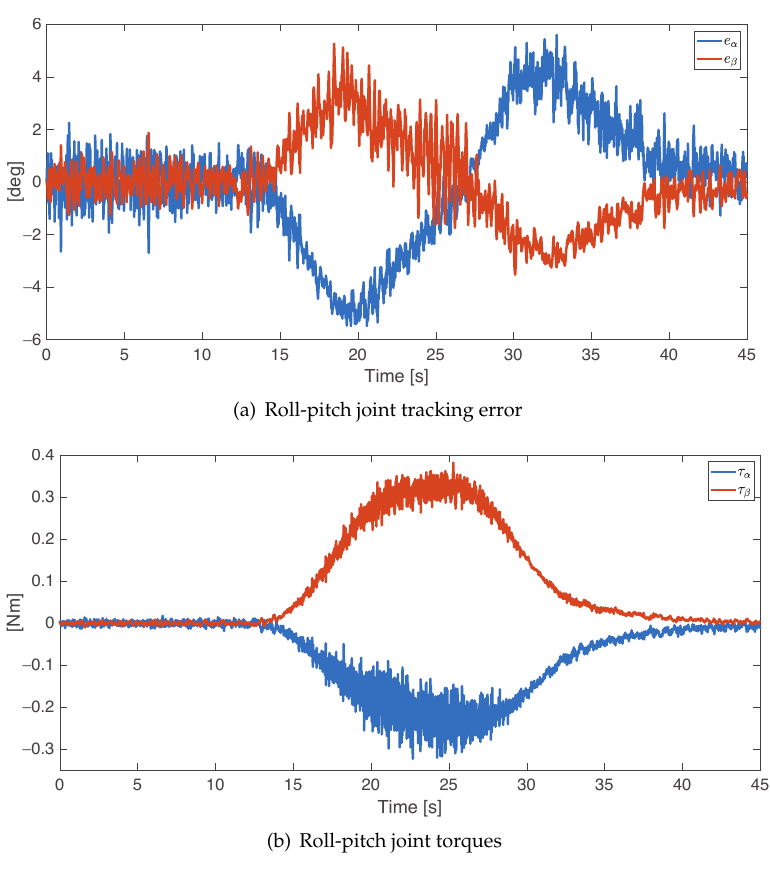
Figure 8. Second case study: roll-pitch joint tracking error ( a ) and torques ( b ). Finally, the estimated interaction forces and torques, computed via the observer (52), are reported in Figure 9a,b. In detail, the force along z axis correctly converges to the load weight (Figure 9a), while small forces along x and y axes are experienced during the transportation, due to the object inertia and the unmodeled ODQuad’s dynamics (Coriolis and friction terms are neglected both in controller and in observer). Regarding the estimated torques (Figure 9b), small torques are experienced around the x and y axes due to the misalignment during the motion between the object and the platform